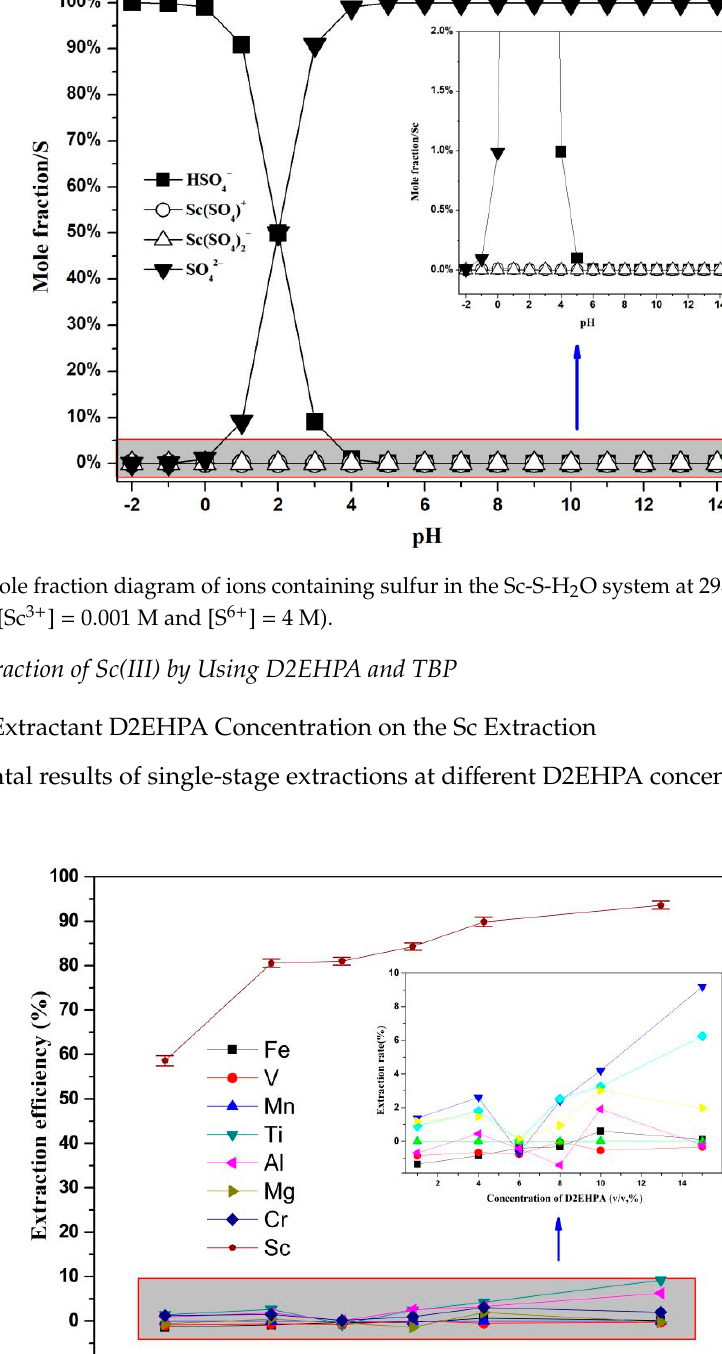
of tri-n-butyl phosphate (TBP), O/A = 1:10, pH = − 0.75 and 5 min at 298 K).